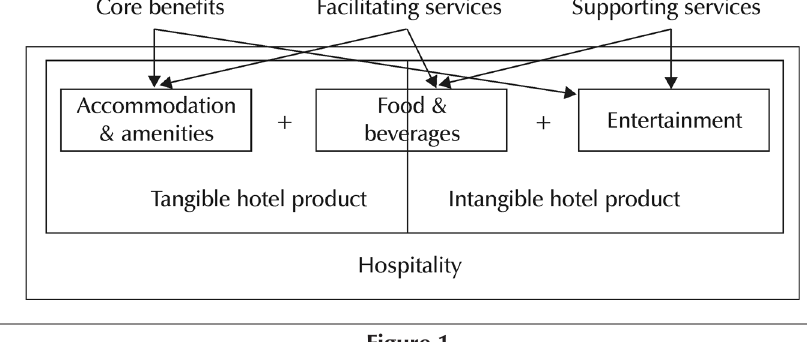
The hotel (product) concept (Source: Diagrammatic interpretation of powers,